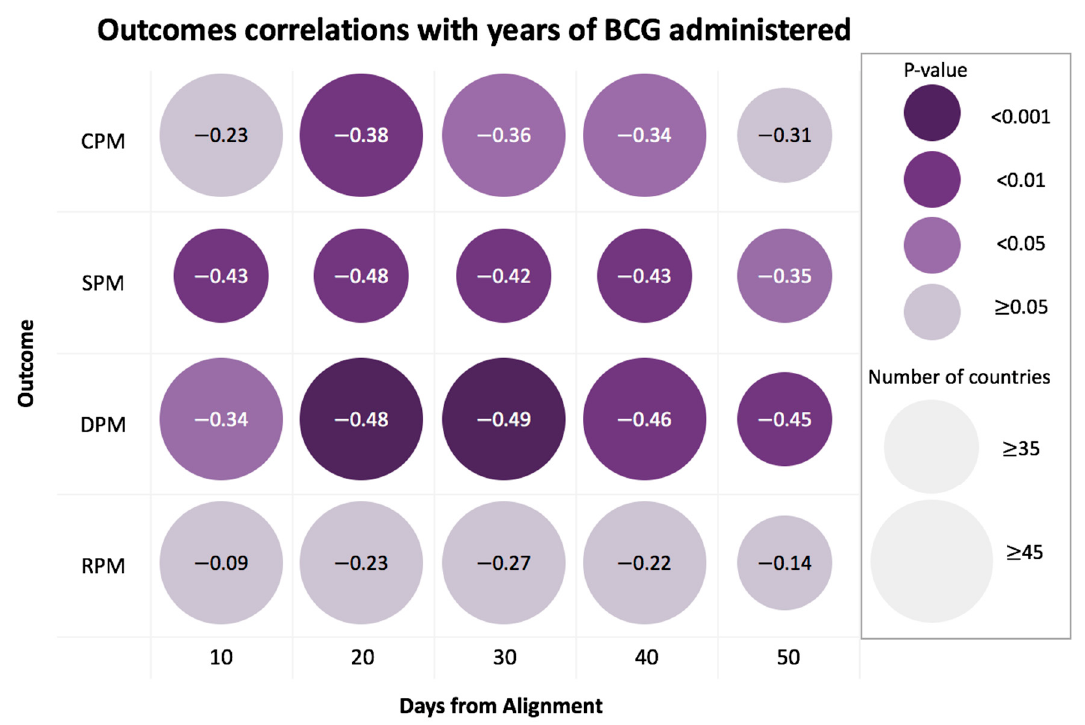
Figure 3. COVID-19 outcomes’ correlations with years of BCG administration. Each row represents a different outcome. Each column represents the time interval of the outcome from the alignment date. Circle size depicts the number of countries, and color represents the statistical significance of the correlation with darker purple color indicating a higher significance. Values in circles are the correlation estimates where all the correlations have negative values. Note that while all countries reached 20 days post alignment of DPM ≥ 0.5, at 50 days post alignment, some countries (5) that were still at an earlier phase of the pandemic at the alignment date failed to provide information. DPM, CPM, SPM and RPM stand for the number per million for death, validated cases, serious and critical conditions and recovered, respectively. For further details, see Table S4.